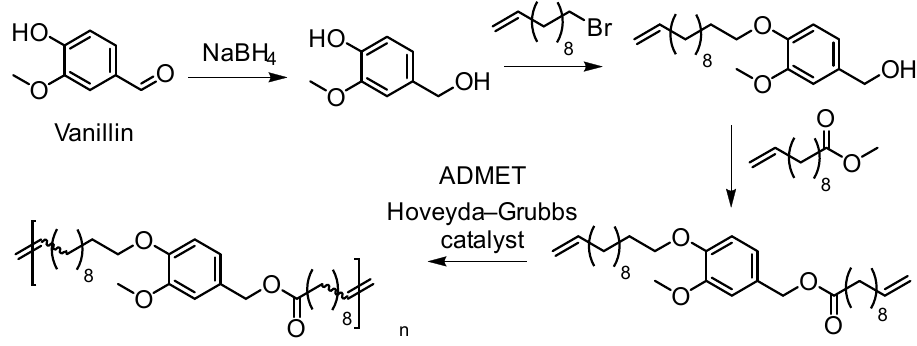
Figure 13. ADMET polymerization of dienes derived from vanillin [51].